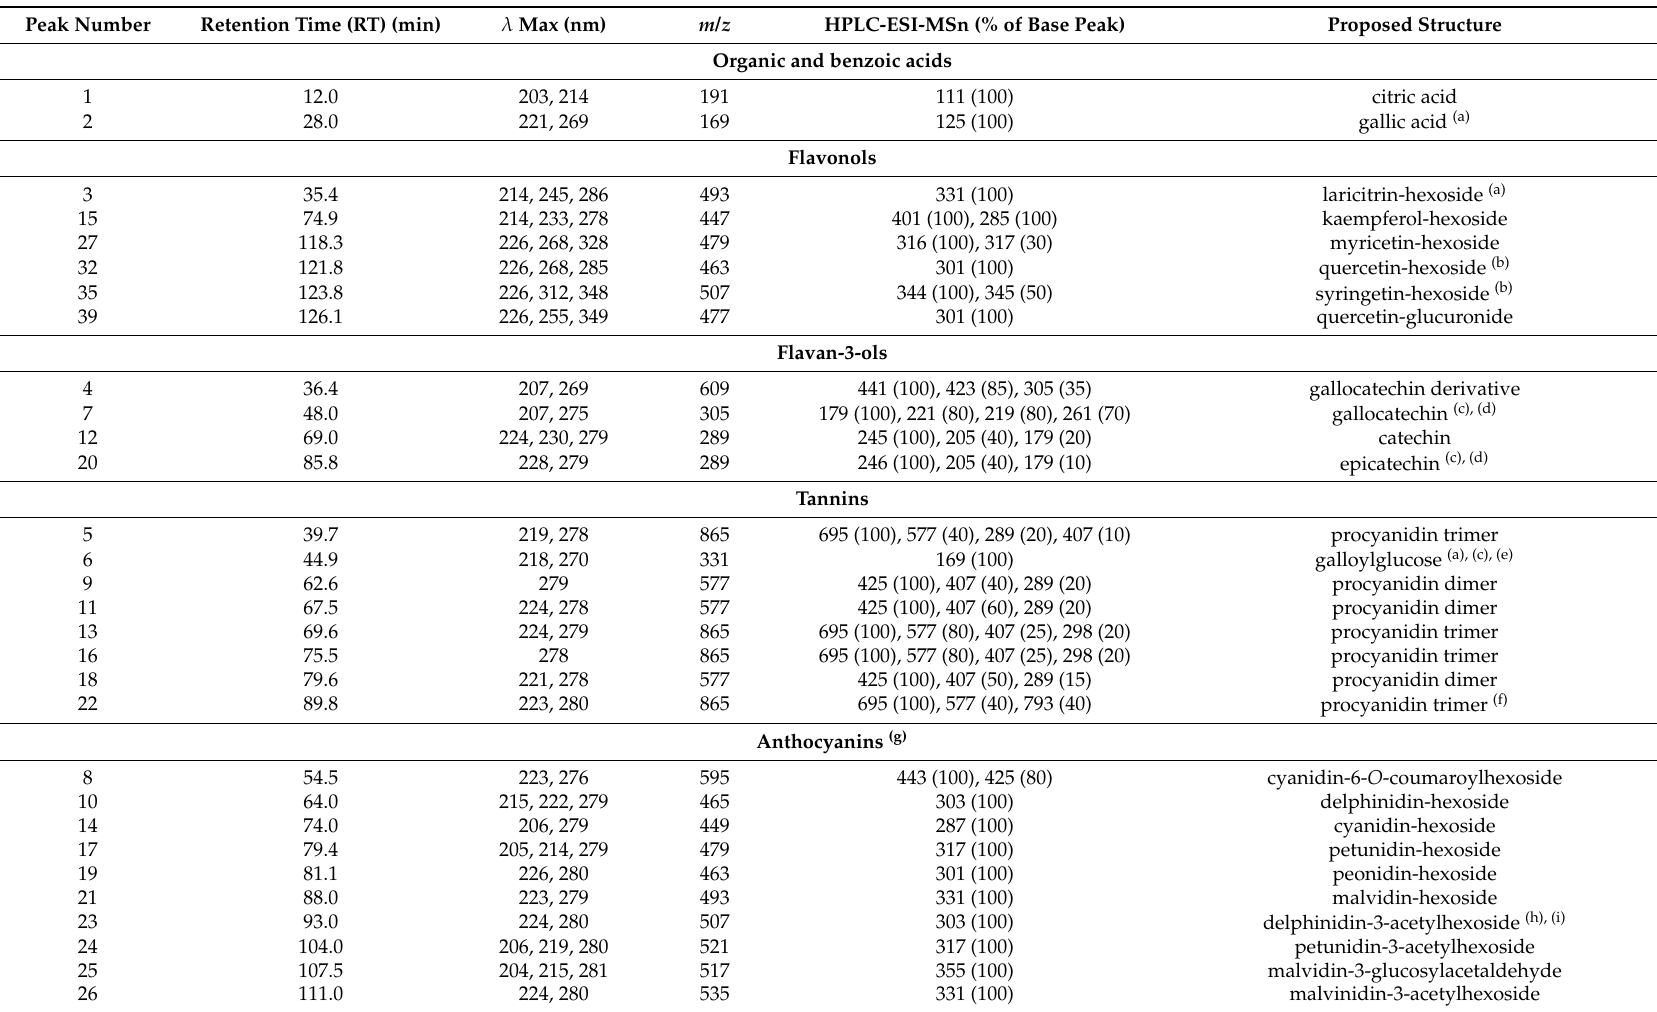
Table 2. Chromatographic behavior, MS and MSn data of the compounds identified in the 15 wine